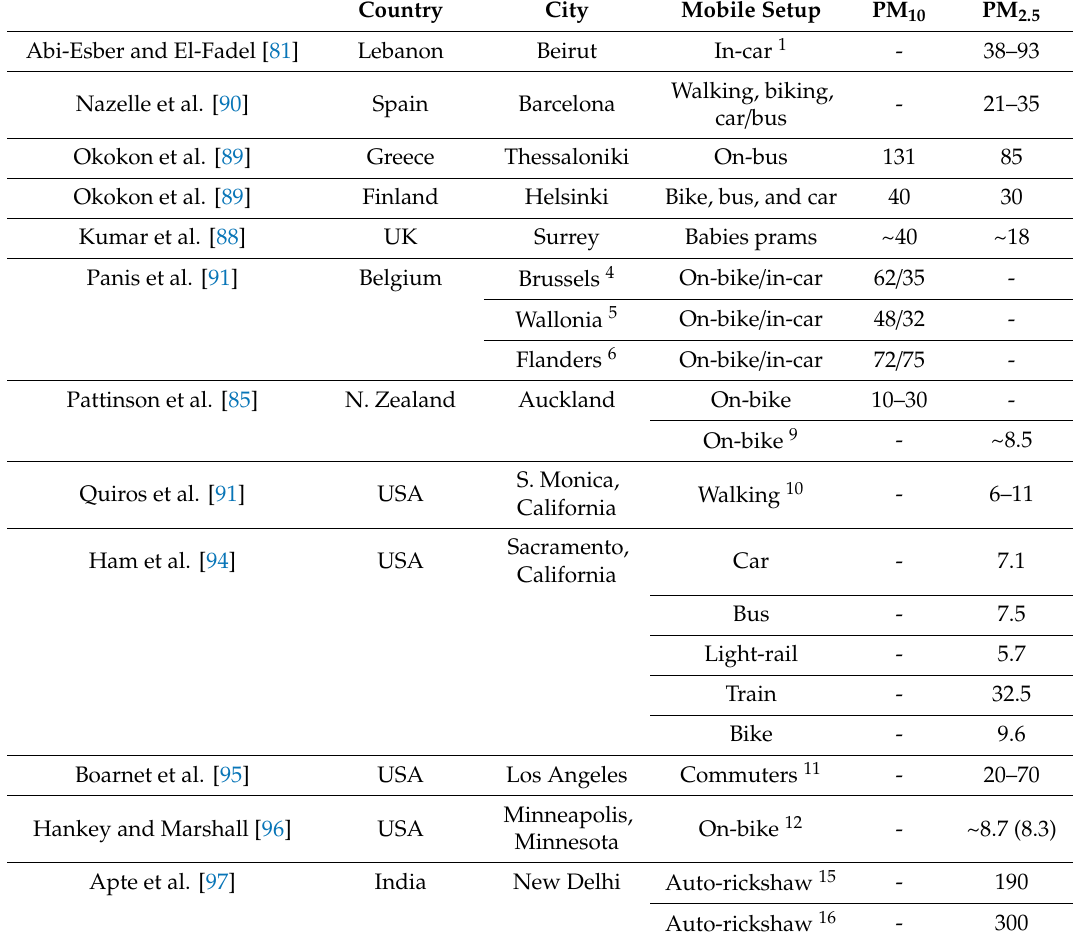
Table 4. Summary of selected literature about mobile measurements of particle mass concentrations ( µ g / m 3 ). Country City Mobile Setup PM 10 PM